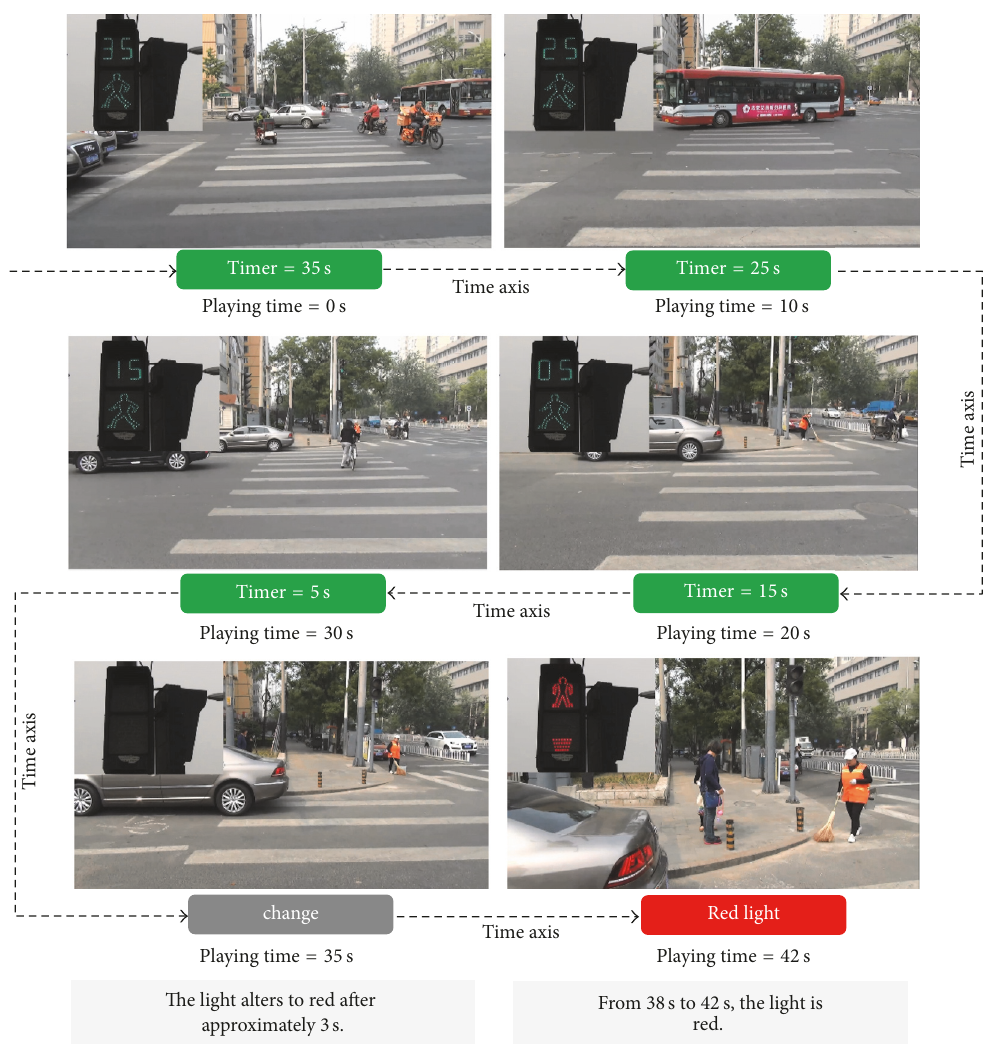
Figure 2: Synthetic video: the time remaining for the pedestrian green light is 35 s.